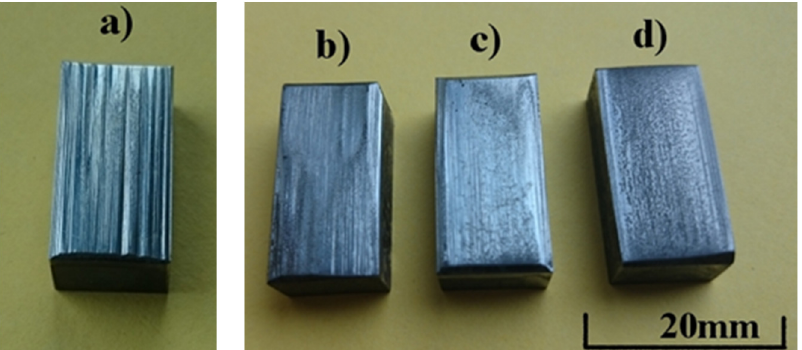
Figure 10. Surface of the samples after the abrasion test: ( a ) reference sample made of GX120Mn13 cast steel; ( b ) high-manganese cast steel with the addition of 5.5% V; ( c ) high-manganese cast steel with the addition of 6.3% V; and ( d ) high-manganese cast steel with the addition of 8.1% V. The abrasive wear of the sample made of Hadfield cast steel is very uneven: deep scratches and furrows are visible on the surface (Figure 10a). The addition of vanadium makes this wear more uniform. With the increasing content of vanadium, the furrows and scratches are smaller, and the surface of the samples becomes “smooth” (Figure 10b,c). The wear of the sample surface is most uniform when the content of vanadium reaches 8.1%